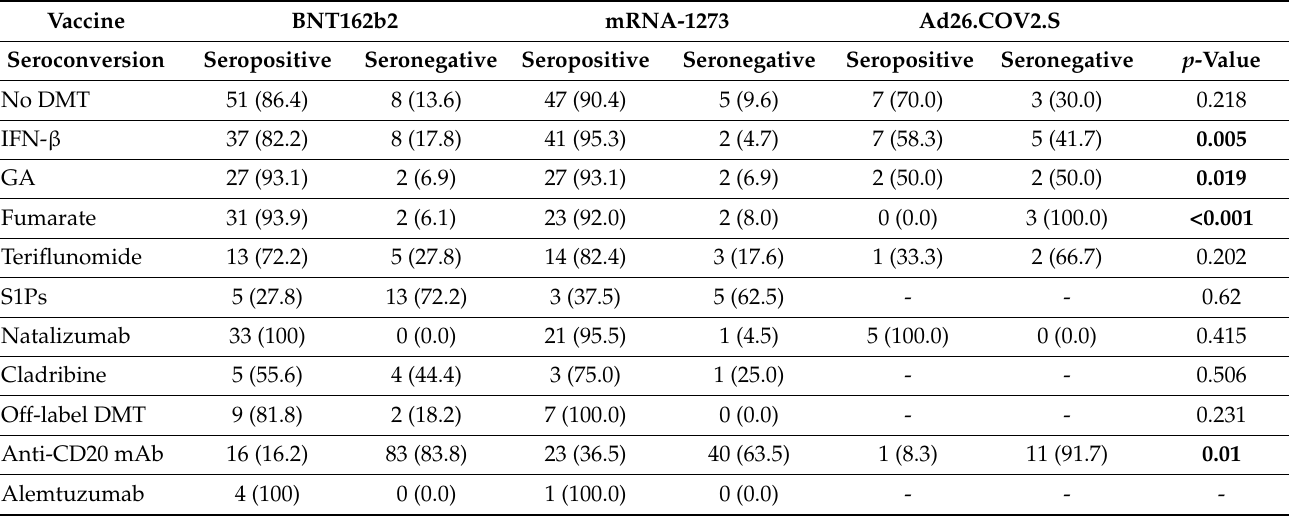
Table 3. Seroconversion and IgG index in PwMS based on COVID-19